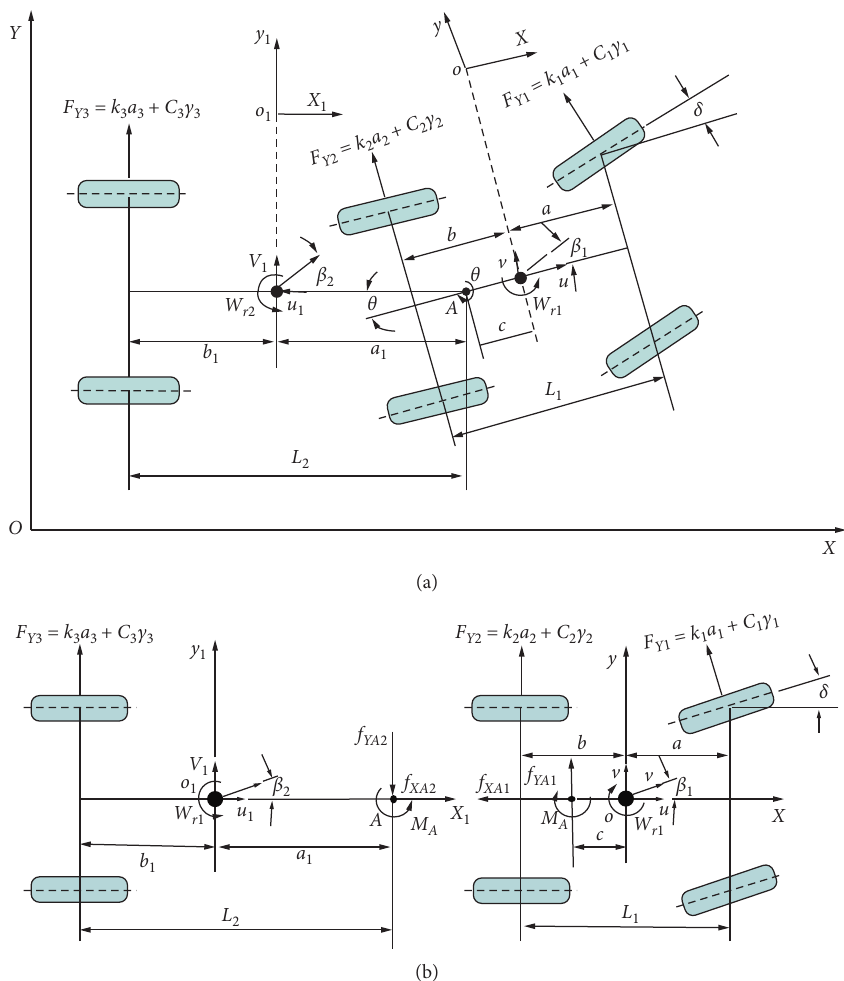
Figure 2: Mechanical model of the complete vehicle system. (a) Model of the motion state. (b) Model of the separation trailer, respectively (m); ω r tractor and trailer centroids, respectively (rad/s); β are the sideslip angles of the tractor and trailer centroids, respectively (degree); and F Y forces of the front, middle, and rear axle of the tire, re- spectively (N). From Figure 2, the equations for tire lateral deflection angle on each axle are